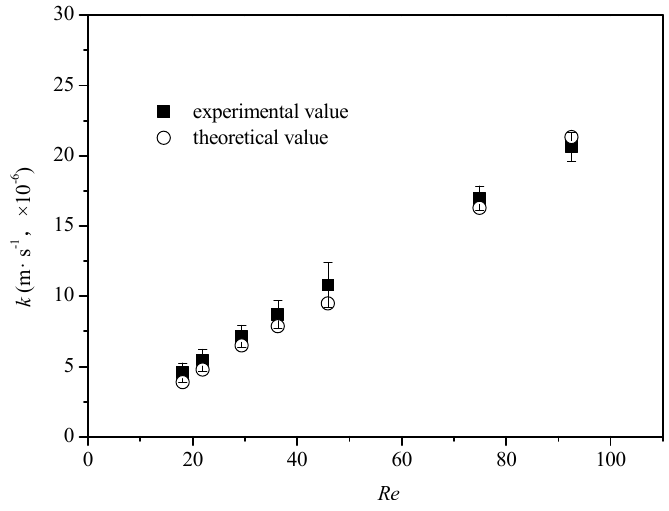
Figure 7. Comparison of the k values.